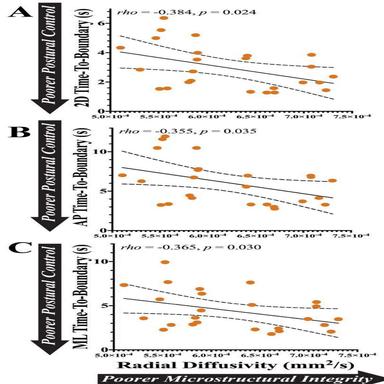
Associations between sensorimotor pathway microstructural integrity and postural control via multi-dimensional quantification in PwMS. Poorer microstructural integrity of the cortical sensorimotor tracts was associated with poorer postural control. These associations are depicted for PwMS in the (A) two-dimensional, (B) anterior-posterior, and (C) medial-lateral orientations; two PwMS failed to complete the compliant surface/eyes open imCTSIB condition and were not included in the correlation analyses.